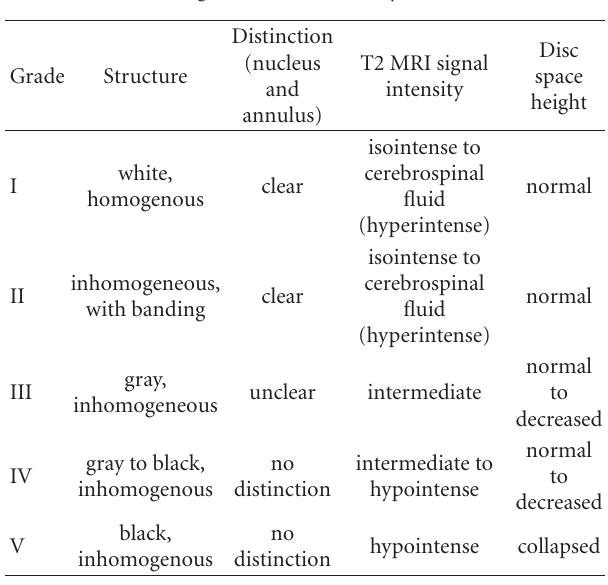
Table 2: Pfirrmann grades as illustrated by Pfirrmann et al.